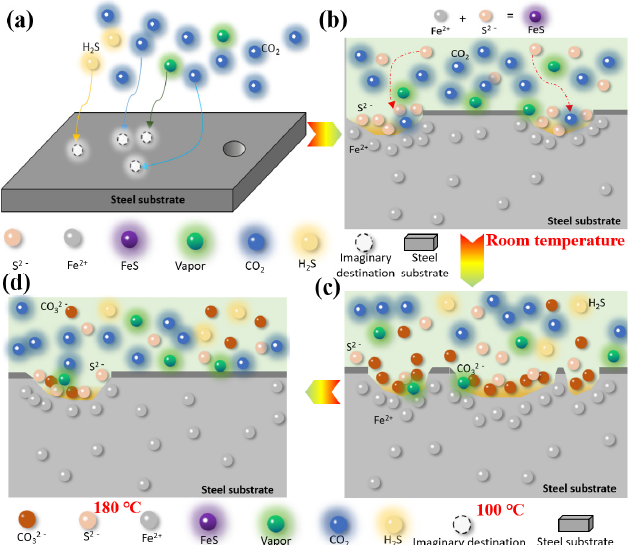
Figure 8. Corrosion models of carbon-steel materials in the environment with H 2 S and CO 2 under different temperatures: ( a ) nucleation and growth of corrosion product film, ( b ) initial stage of product membrane damage, ( c ) severe damage of product membrane, ( d ) product membrane repair stage.